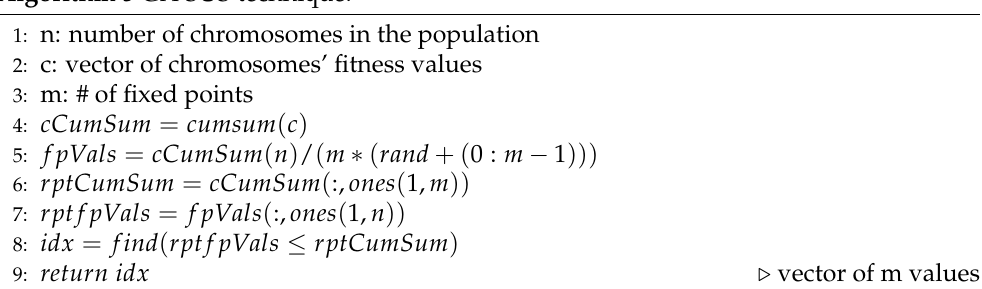
Algorithm 5 GA SUS